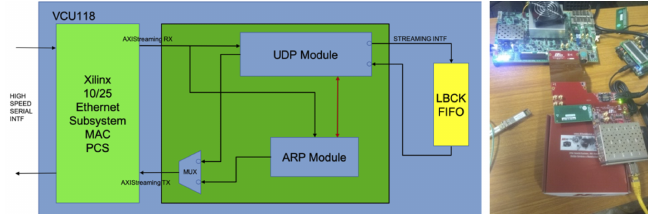
Figure 1. Testbed for the 1 / 10GbE UDP / IP links